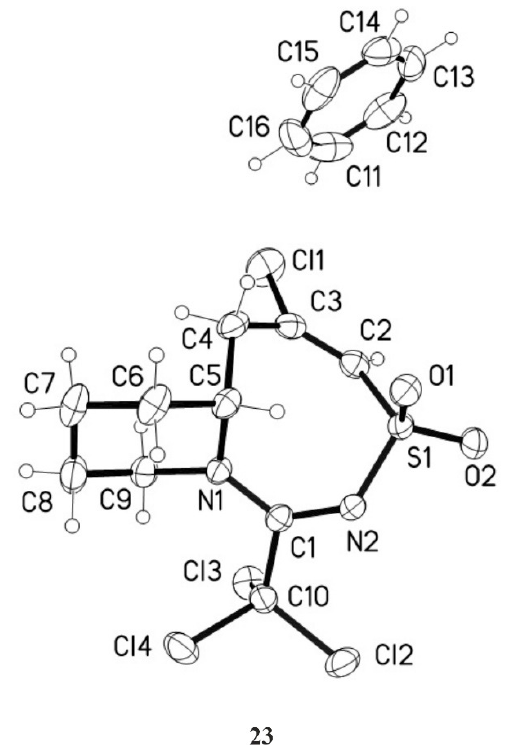
Figure 8. Molecular structure of novel pyrido[1,2 ‐ d ][1,2,4]thiadiazocine heterocyclic system 23 including thermal displacement ellipses with 50% probability.